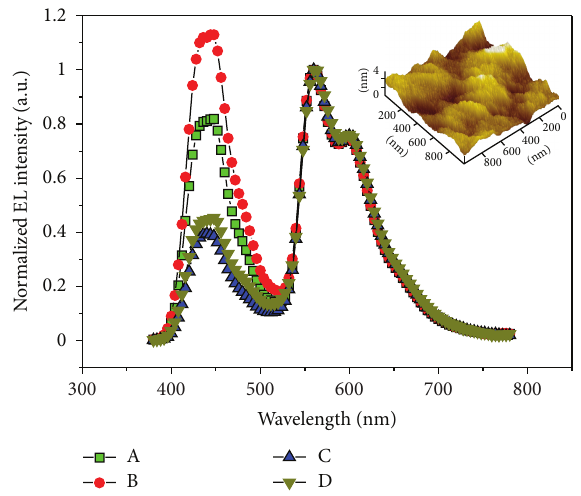
bias (normalized with the emission peak at 560nm, device A: 3 wt% doping and mixed CPB: NPB thin layer; device B: 3 wt% doping and pure NPB thin layer; device C: 5wt% doping and mixed CPB:NPB thin layer; device D: 5wt% doping and pure NPB thin layer). The inset was the AFM testing result of 30nm NPB film on glass